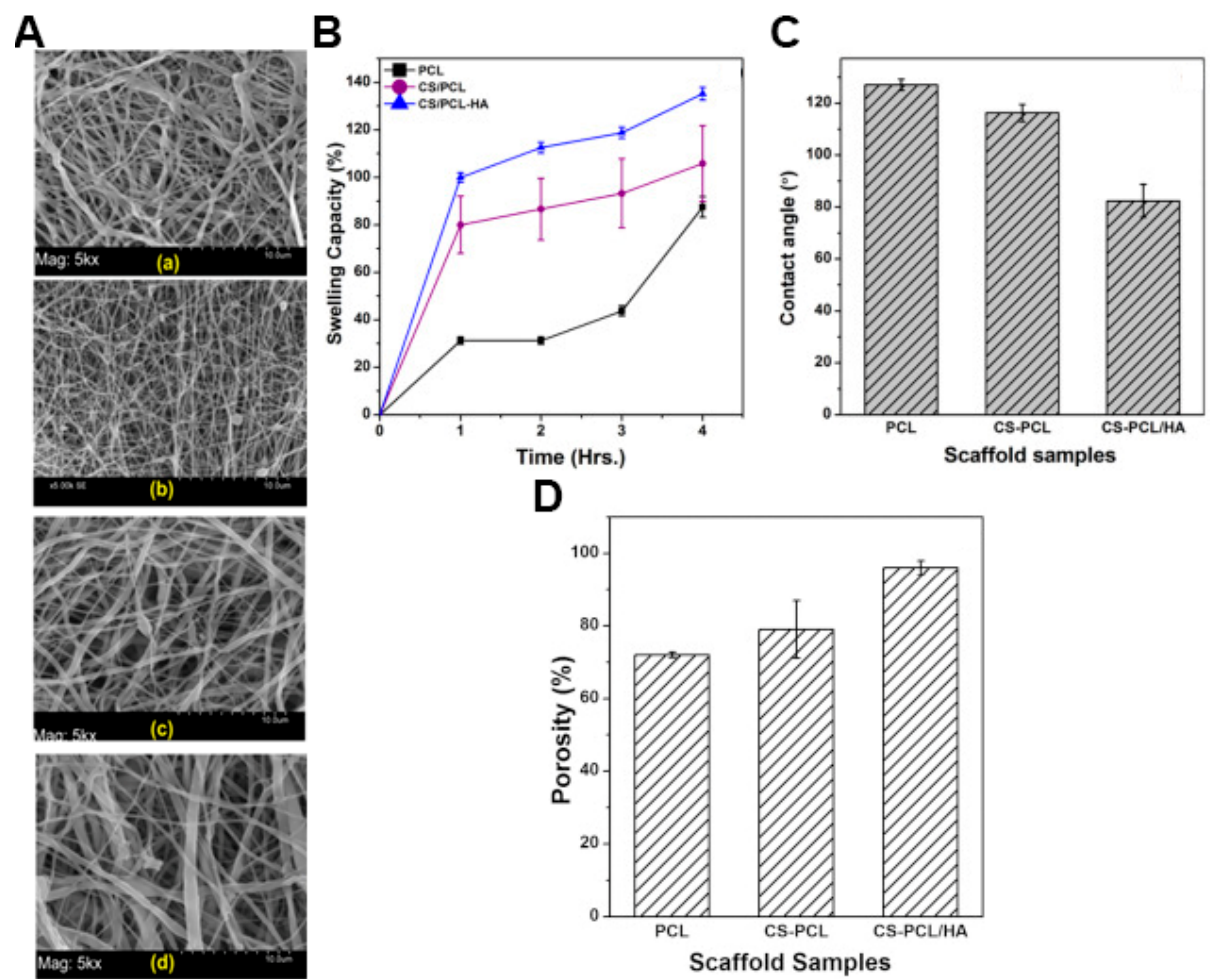
Figure 3. ( A ) SEM photomicrographs, with magnification of 5000 × , of electrospun scaffolds of (a) poly(caprolactone) (PCL), (b) chitosan (CS)/PCL, (c) hyaluronic acid/polyethylene oxide (HA/PEO), (d) CS/PCL-HA. Physicochemical properties of only PCL membrane, CS-PCL membrane (top layer), and CS-PCL/HA asymmetric membrane; ( B ) swelling capacity of the scaffolds; ( C ) water contact angles of the scaffolds; ( D ) porosity of the scaffolds. Reprinted with permission from [26], Elsevier, 2018.